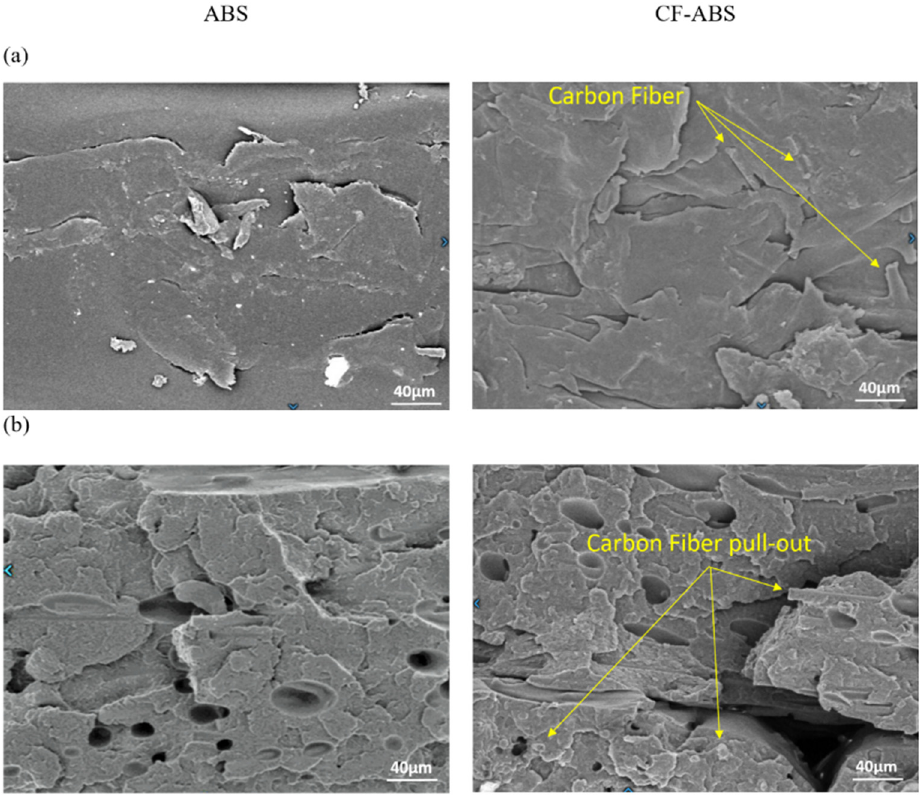
Figure 8 . Microscopic Evaluation of Mechanical Tested ABS versus CF-ABS [1000×] ( a ) Tensile Load- ing ( b ) Compressive Loading . Loading ( b ) Compressive